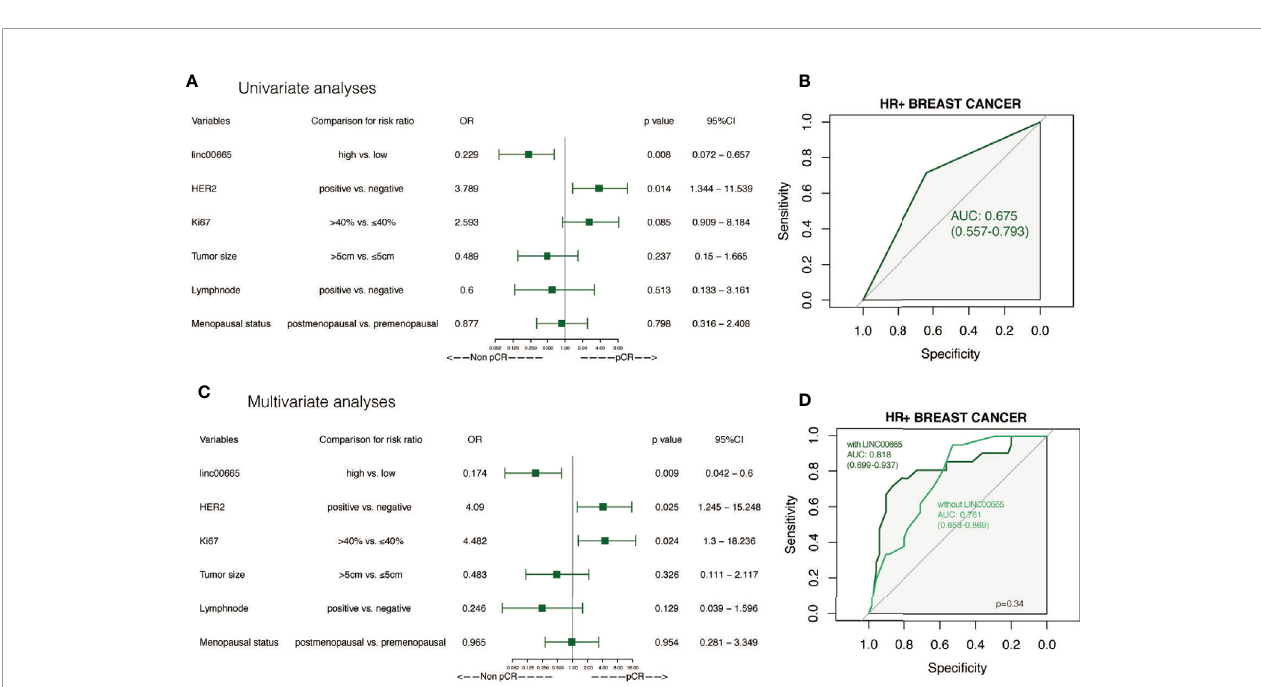
FIGURE 3 | The predictive value of Linc00665 expression in pCR in HR-positive population (A) Univariate logistic regression analysis of potential predictive markers in HR-positive patients; (B) Performance of Linc00665 expression in predicting pCR evaluated by ROC in HR-positive patients; (C) Multivariate logistics regression analysis of potential predictive markers in HR-positive patients; (D) ROC of multivariate logistic regression including clinicopathological factors with or without Linc00665 expression in HR-positive patients.